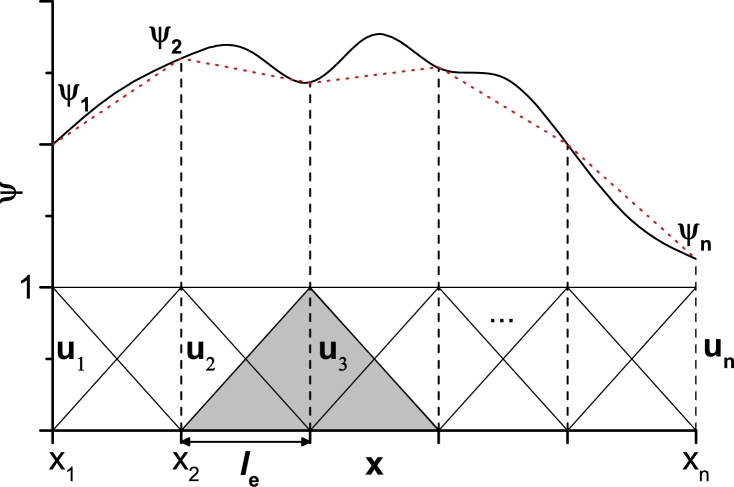
Illustration of the FEM discretization. The un are linear base functions and ψn are the coefficients that adjust the numerical solution to the exact solution.